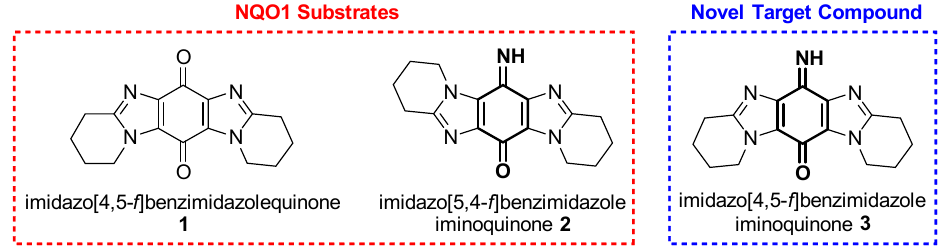
Figure 1. Rational drug design: targeting of iminoquinone 3 based on reported NAD(P)H:quinone oxidoreductase 1 (NQO1) substrates.